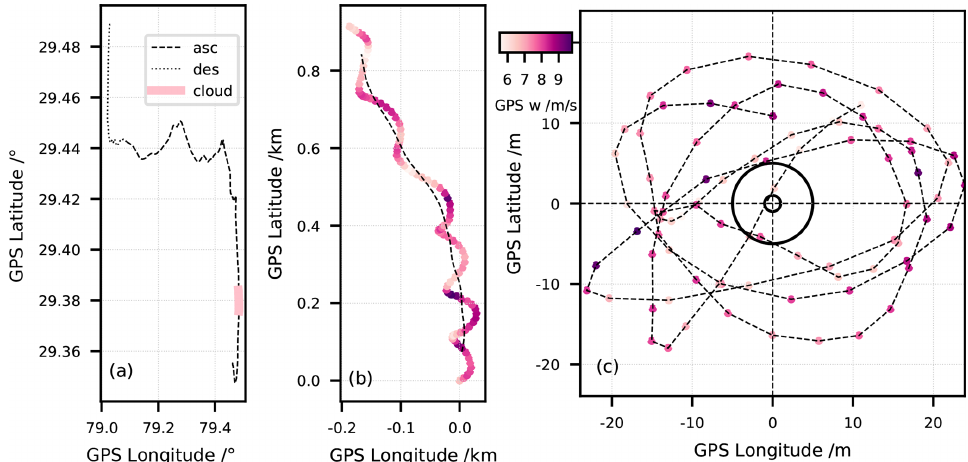
Figure 5. Pendulum analysis for the section of flight NT011 traversing the mixed-phase cloud. (a) Payload trajectory for the entire flight: ascent (dashed), descent (dotted) and mixed-phase cloud between 9.25 and 10km altitude (thick pink line). (b) Zoom-in on the mixed- phase cloud with 1s GPS data of payload trajectory (symbols) and derived balloon trajectory (dashed). (c) Detrended payload oscillations; approximate balloon sizes on the ground ( r = 1m) and at burst ( r = 5m) are shown by two circles. Colour code in panels (b) and (c) : balloon ascent velocity.